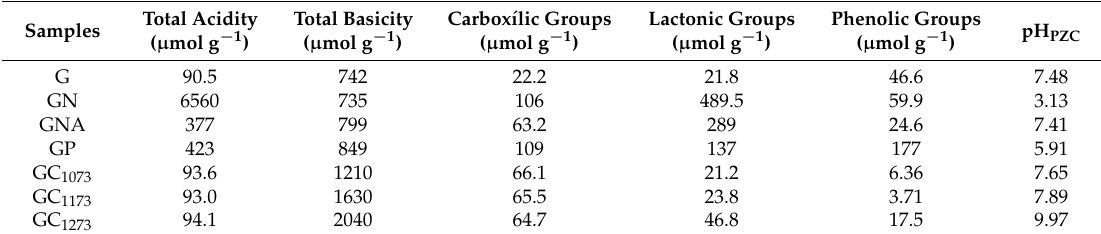
Table 3. Chemical parameters of the activated carbons.